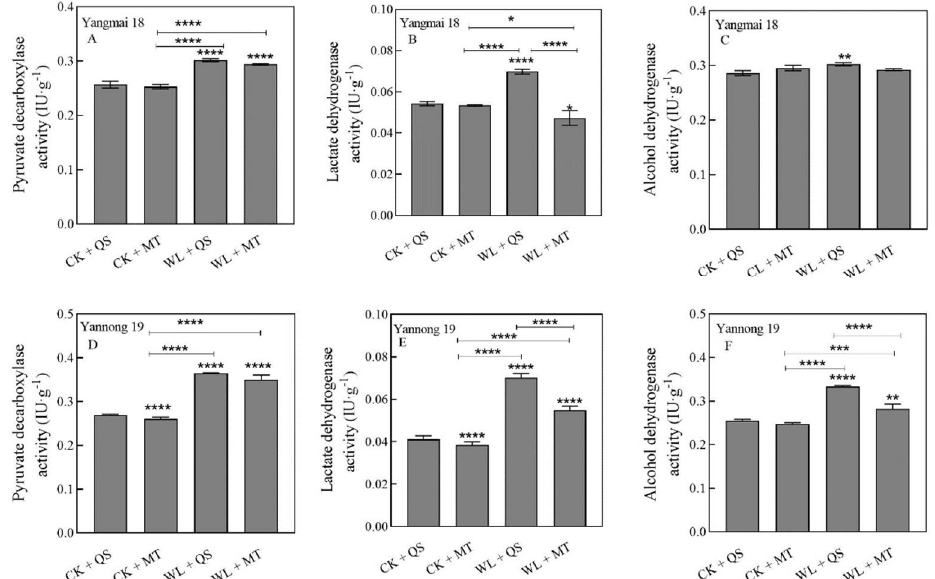
Figure 6. Post-flowering changes in root enzymes’ activities related to anaerobic respiration of Yangmai 18 ( A – C ) and Yannong 19 ( D – F ) under different treatments, i.e., CK + QS: leaf spraying with distilled water under non-waterlogged conditions; CK + MT: leaf spraying with 100 μmol·L −1 of melatonin under non-waterlogged conditions; WL + QS: leaf spraying with distilled water under waterlogged conditions; WL + MT: leaf spraying with 100 μmol·L −1 of melatonin under waterlogged conditions. * Significance at the 0.05 level, ** significance at the 0.01 level, *** significance at the 0.001 level, **** significance at the 0.0001 level.